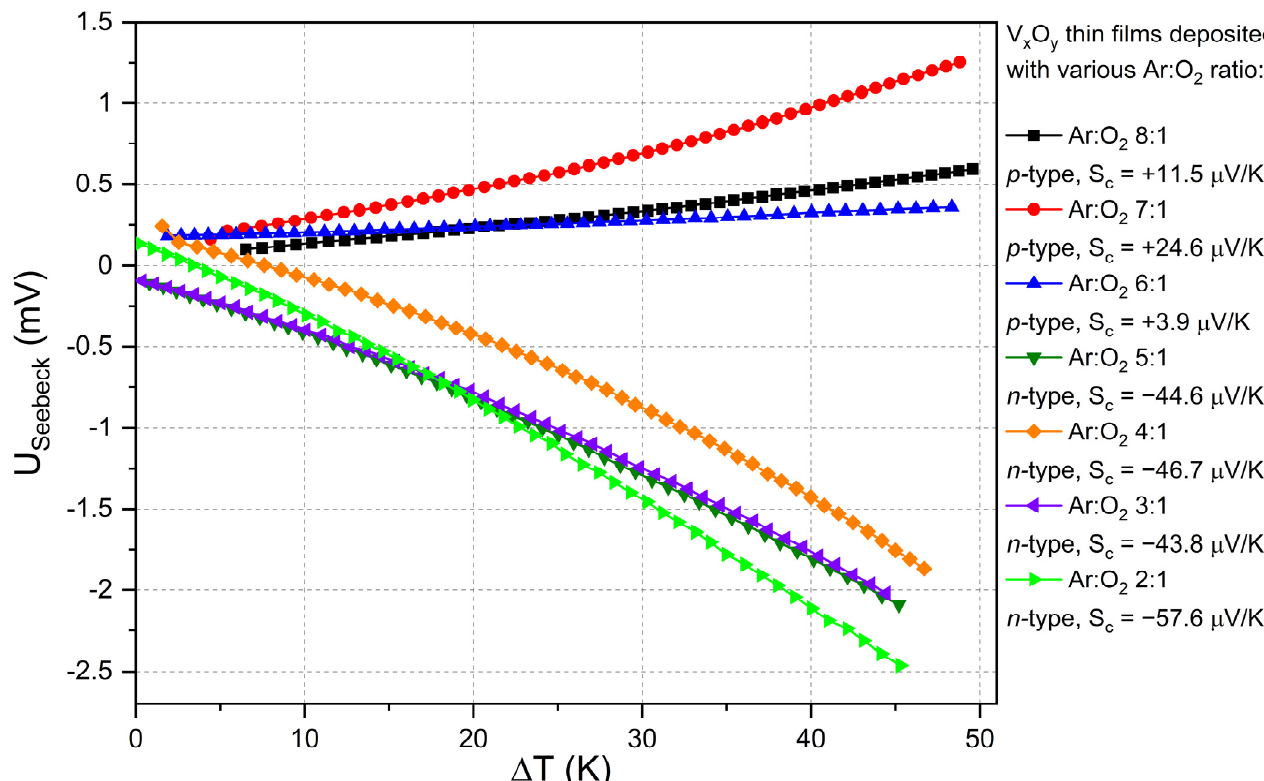
Figure 11. Thermoelectric characteristics of vanadium oxides thin films deposited with various Ar:O 2 gas ratios.